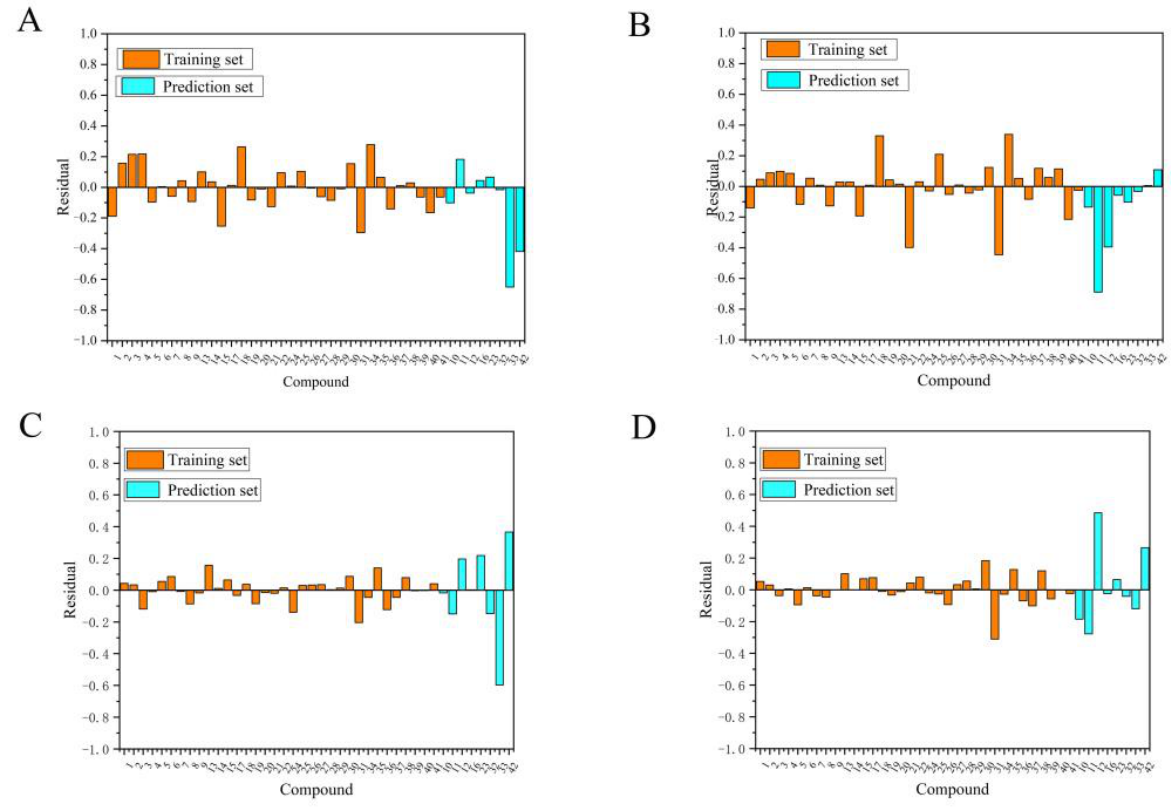
Figure 3. The errors between the experimental values and the predicted values for CoMFA and CoMSIA based on ligand-based approach and receptor-based approach were shown in panels ( A – D ), respectively. The shorter the bar is, the better the model prediction is.